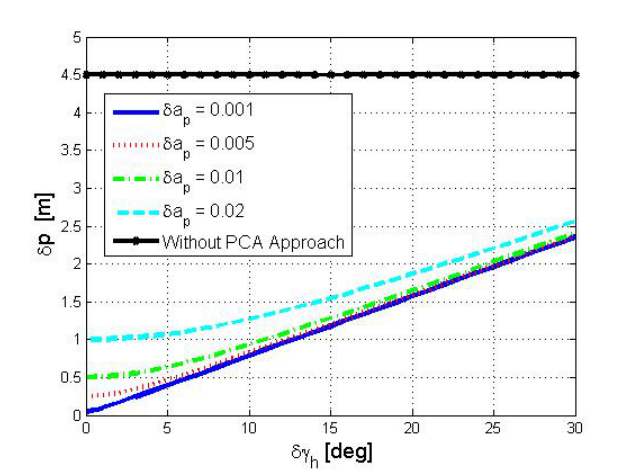
Figure 9. Numerical positioning error of the DR procedure.